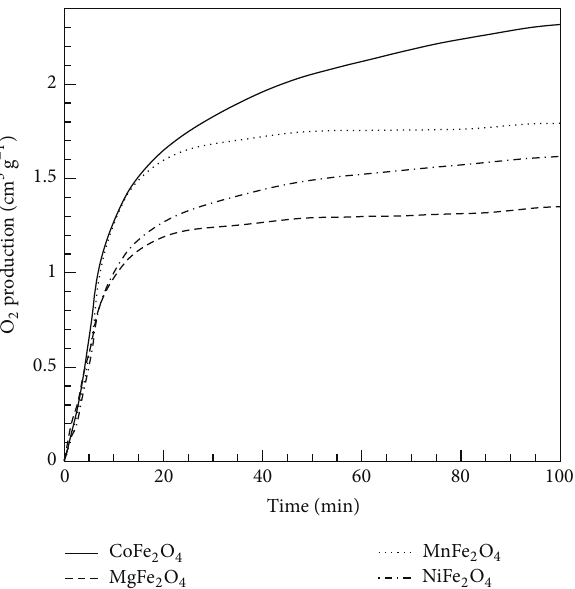
Figure 11: O 2 production of all samples at the 5th cycle.